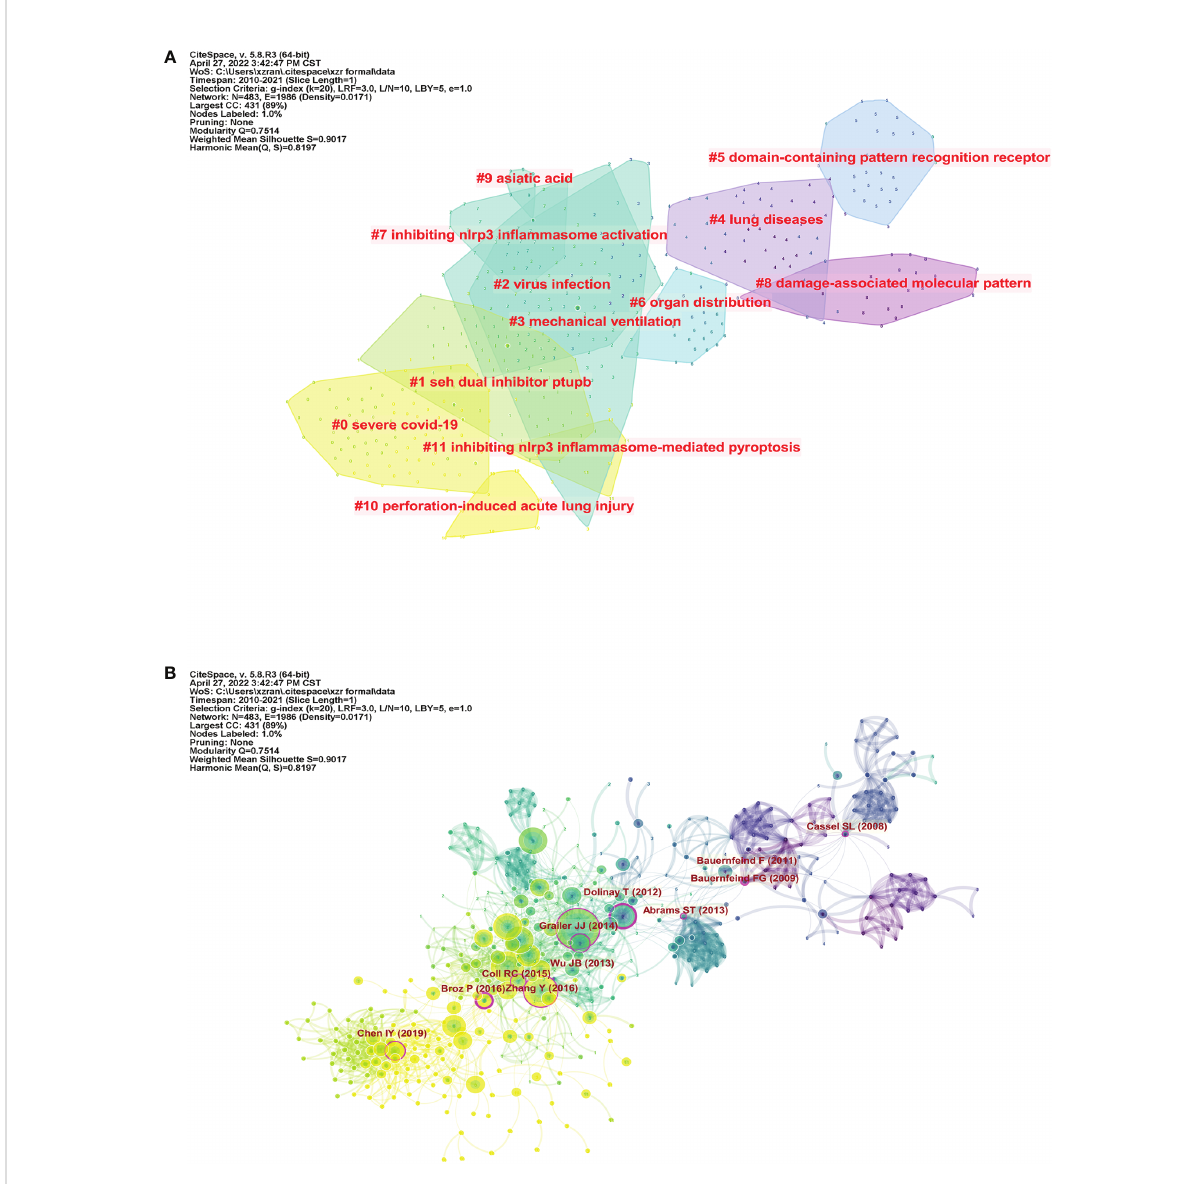
FIGURE 7 Mapping on co-cited references of NLRP3 in ALI/ARDS. (A) The major clusters of the co-citation network. (B) The co-citation network of the 508 references. Every node represents a document, and lines re fl ect co-citation strength. Connective papers with high centrality value are marked with purple